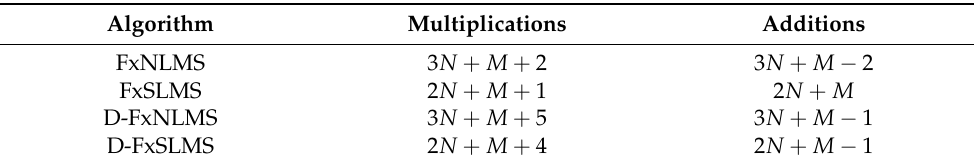
Table 1. Number of multiplications and additions per iteration of the FxNLMS, FxSLMS, D-FxNLMS and D-FxSLMS for a single-channel ANC